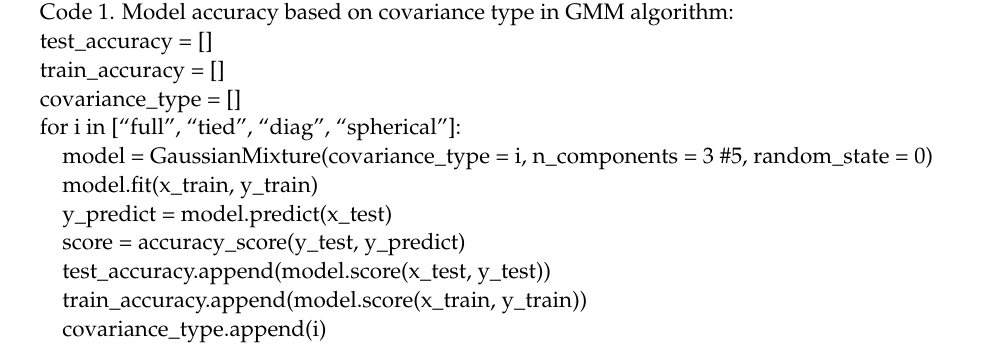
Code 1. Model accuracy based on covariance type in GMM